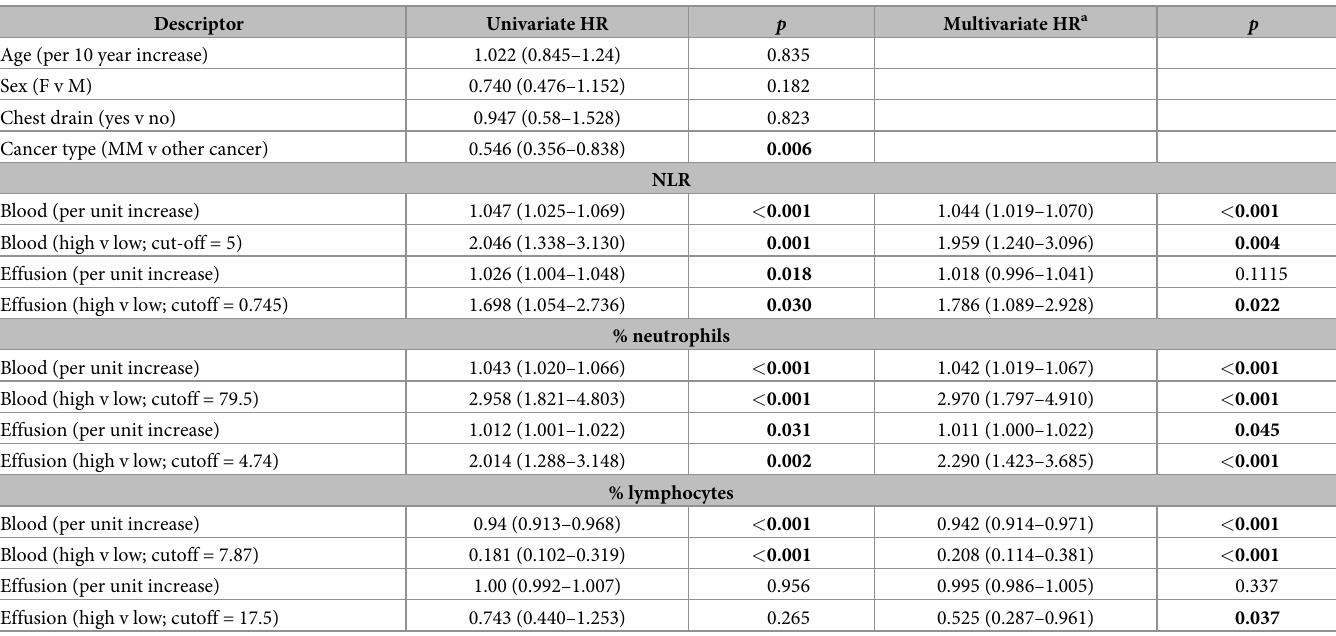
Table 3. Survival analysis for patients with